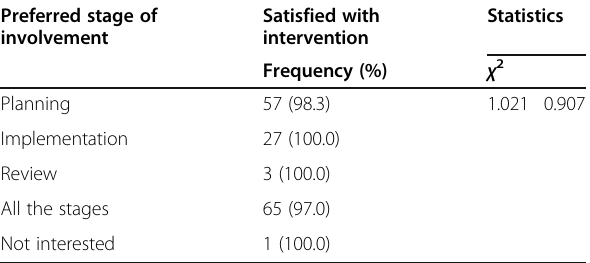
Table 7 Respondents desire to participate in the intervention against satisfaction with the intervention received ( n =156) Preferred stage of